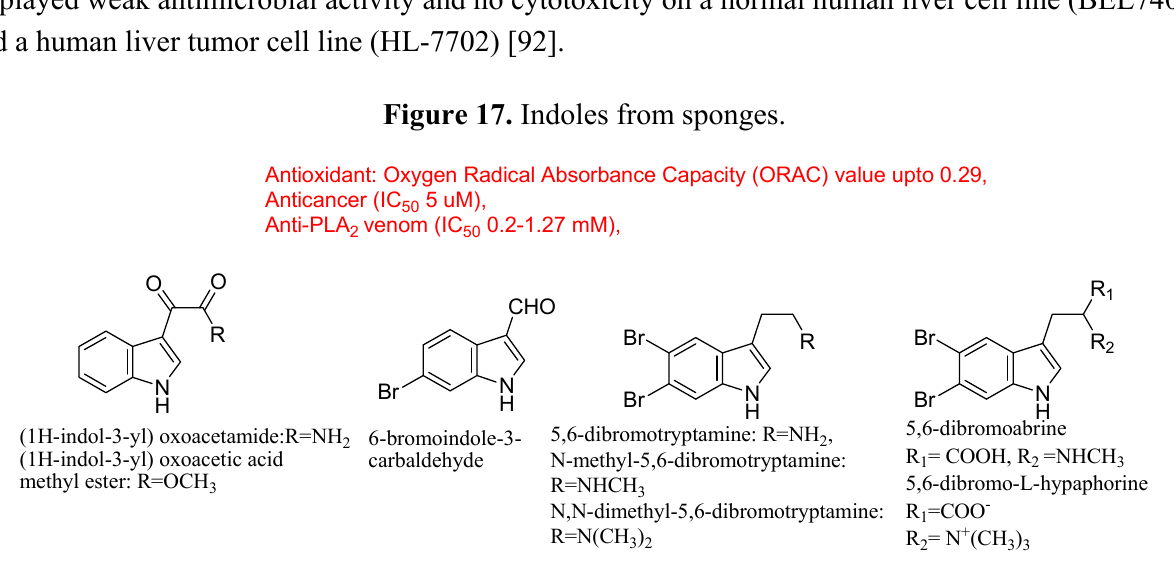
DNA intercalator